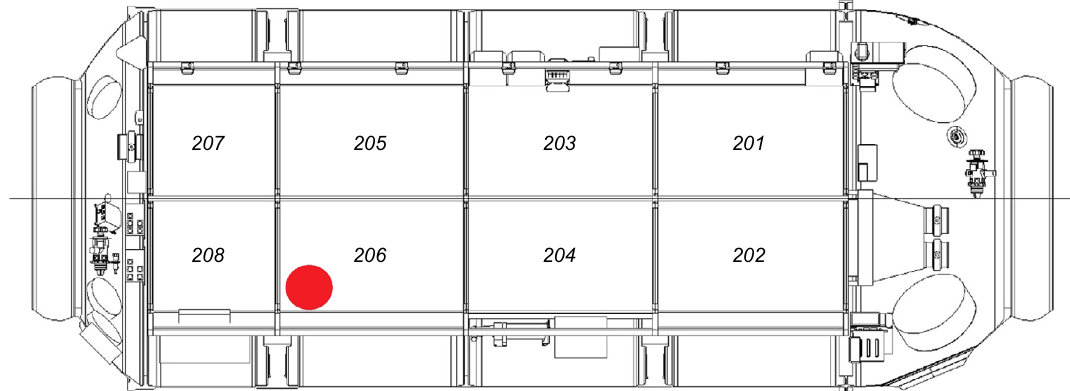
Fig. 3. Sketch of the panels on the right board of MIM1 ISS module. The spherical phantom (red circle) is behind panel 206.